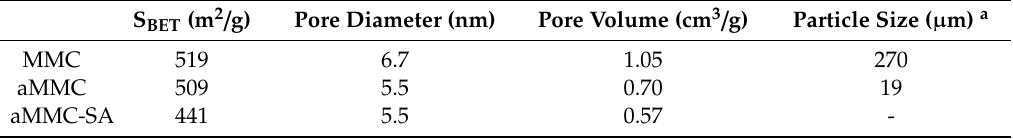
Table 1. Specific surface area (S BET ) and pore properties of the studied samples. S BET (m 2 /g)